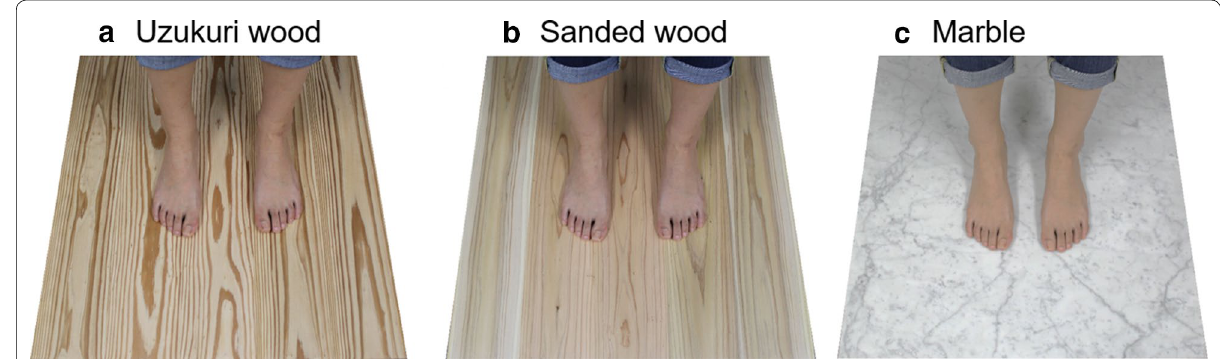
Fig. 1 Materials used in the tactile experiment. a Uzukuri wood: the surface of Japanese cedar material was uncoated and finished by brushing with a stainless-steel wire brush. b Sanded wood: the surface of Japanese cedar material was uncoated and finished by sanding it with an abrasive-band machine. c Buffed marble: the control